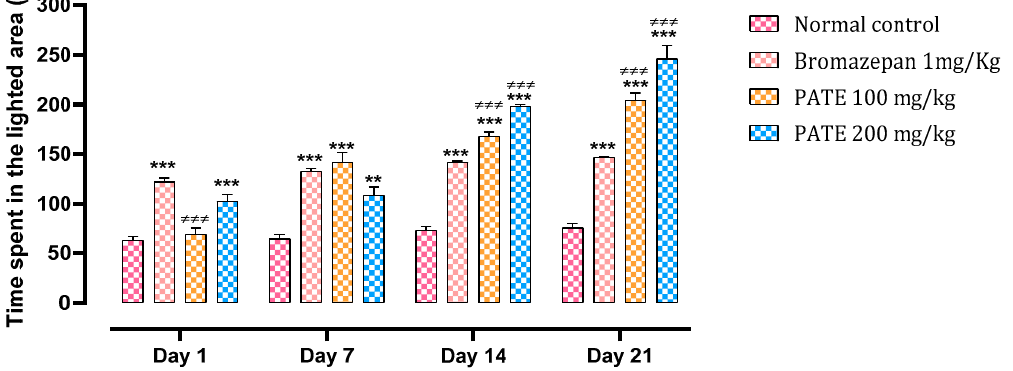
Figure 4. Effect of PATE on the variation in time spent in the lighted chamber in mice. Data are represented as mean ± SEM. (*** p ≤ 0.001 compared to the negative control. ≠≠≠ p ≤ 0.001 compared to the positive control).